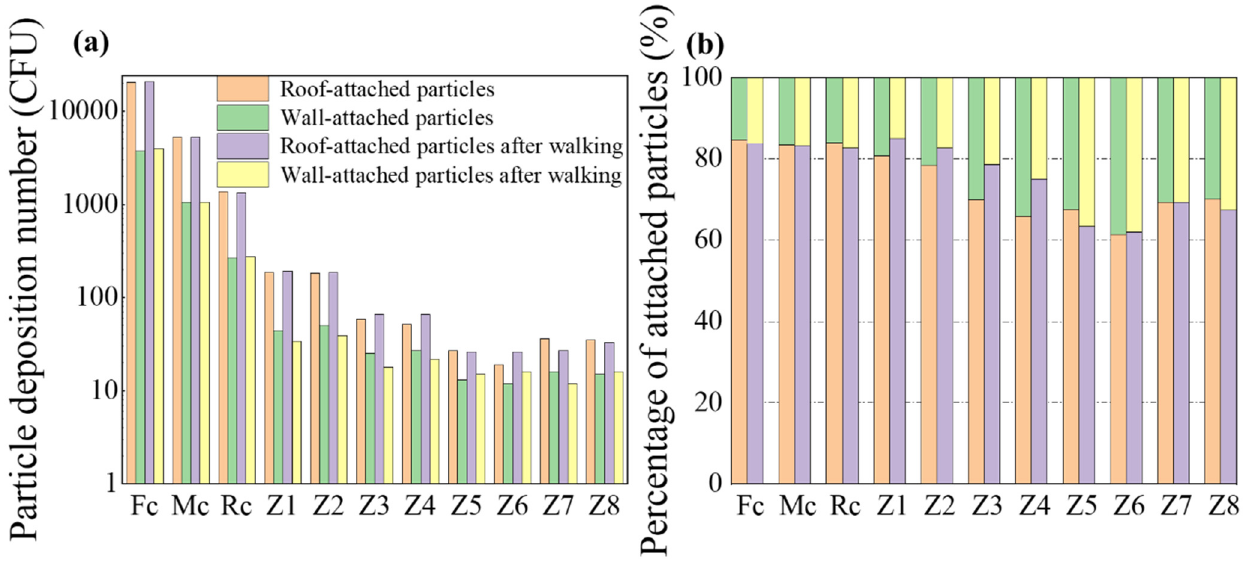
Figure 7 . Distribution of deposition BPs in different chambers at time = 900 s both visitor walking and standing up: ( a ) the number of BPs on the walls and rooves; ( b ) the proportion of BPs on the walls and rooves.